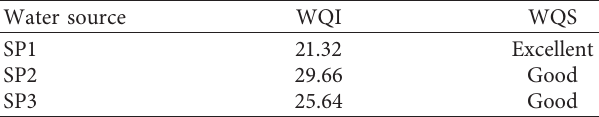
Table 5: Water quality index and water quality